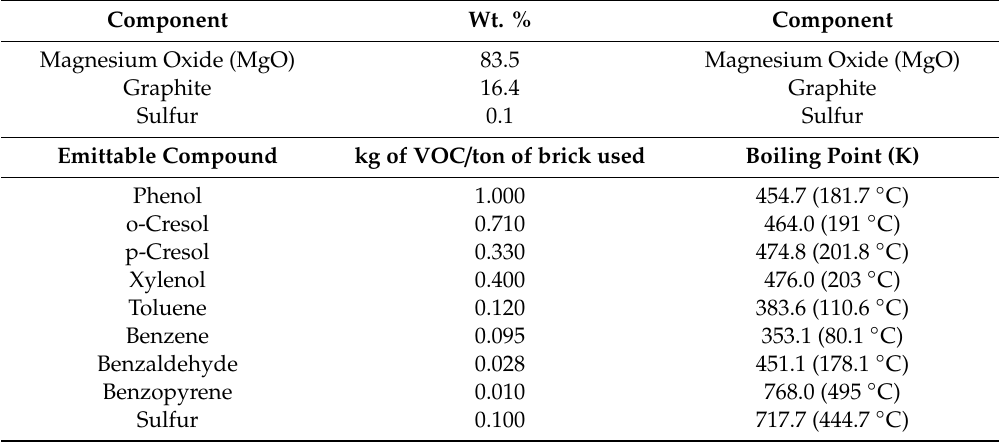
Table 1. Composition of bricks and properties of emittable compounds in refractory lining